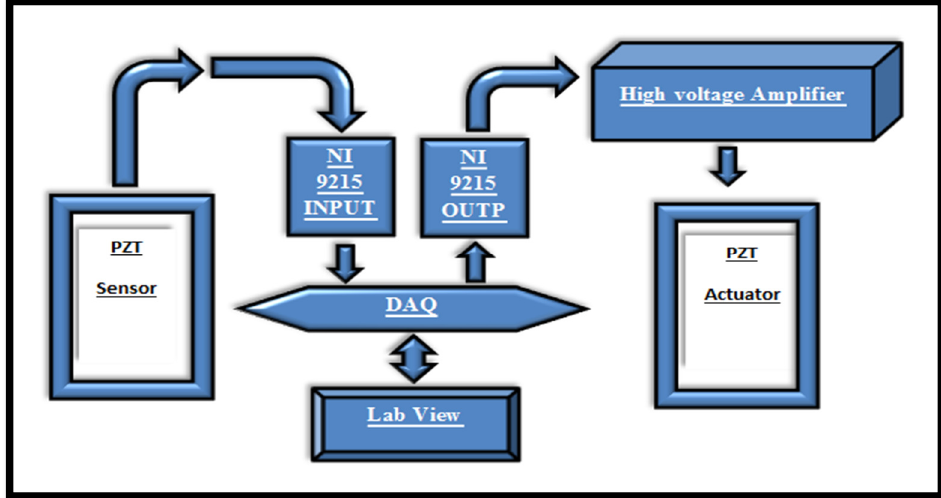
Fig. 8. The diagram of experimental active vibration control